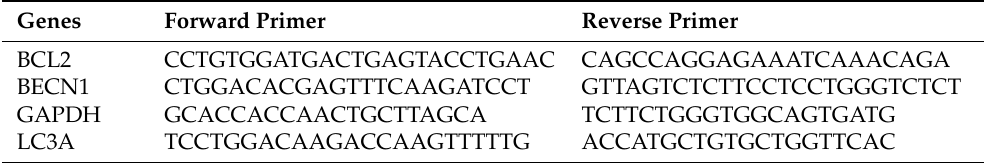
Table 1. The primer sequences of real-time